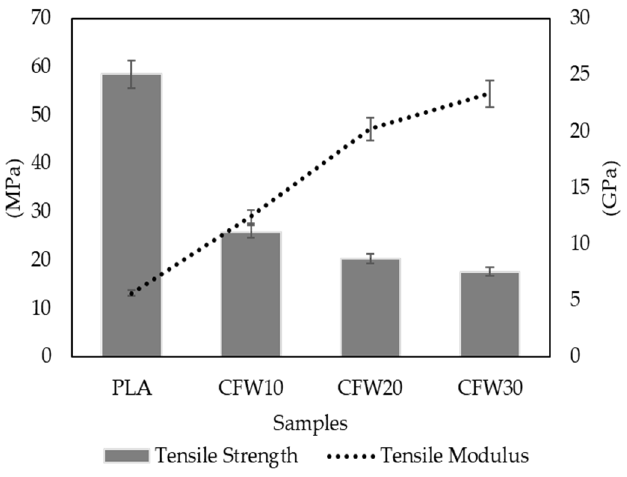
Figure 2. Tensile strength and tensile modulus of PLA/CFW.